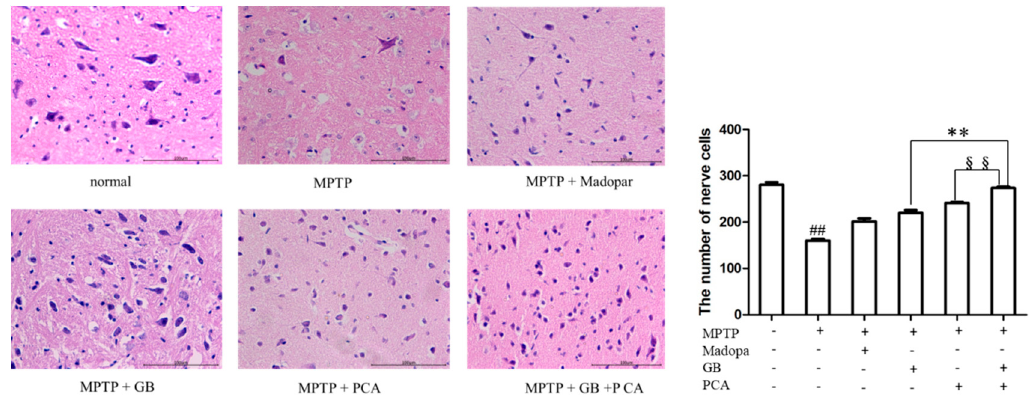
Figure 5. Morphological and quantitative changes in the neurons of mouse midbrains were observed by HE staining (200×). ## p < 0.01 vs. the normal group, ** p < 0.01 vs. the GB-treated group, §§ p < 0.01 vs. the PCA-treated